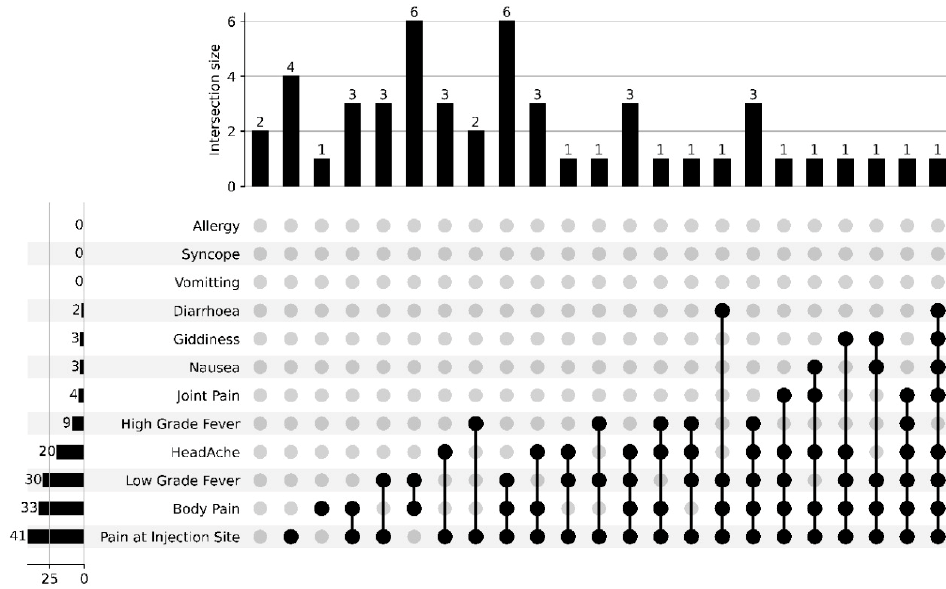
Figure 2. Upset plot representing reported side-effects and co-existence of symptoms after the first dose of the vaccine. The values represent the number of individuals experiencing a symptom category or combination of categories. Black lines link multiple symptoms indicated by black dots.